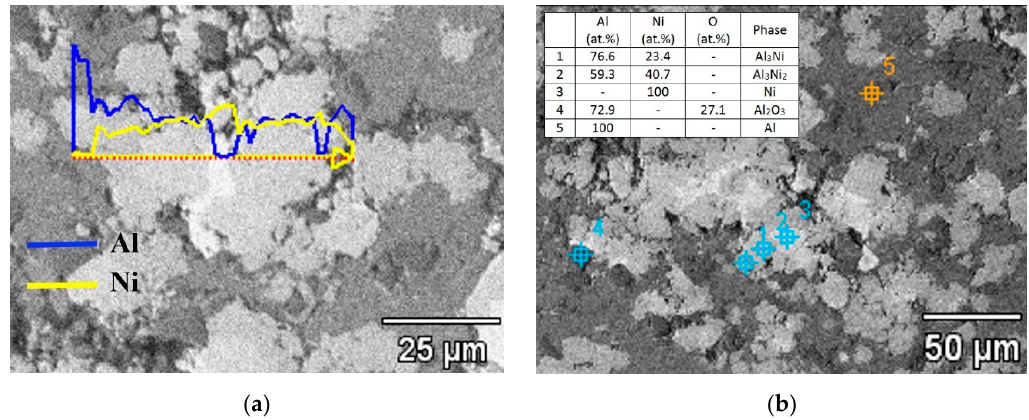
Figure 12. EDS analysis of 16% Al coating: heated in a furnace at 620 °C ( a ) and heated by resistance spot welding process with parameters 4 ( b ).